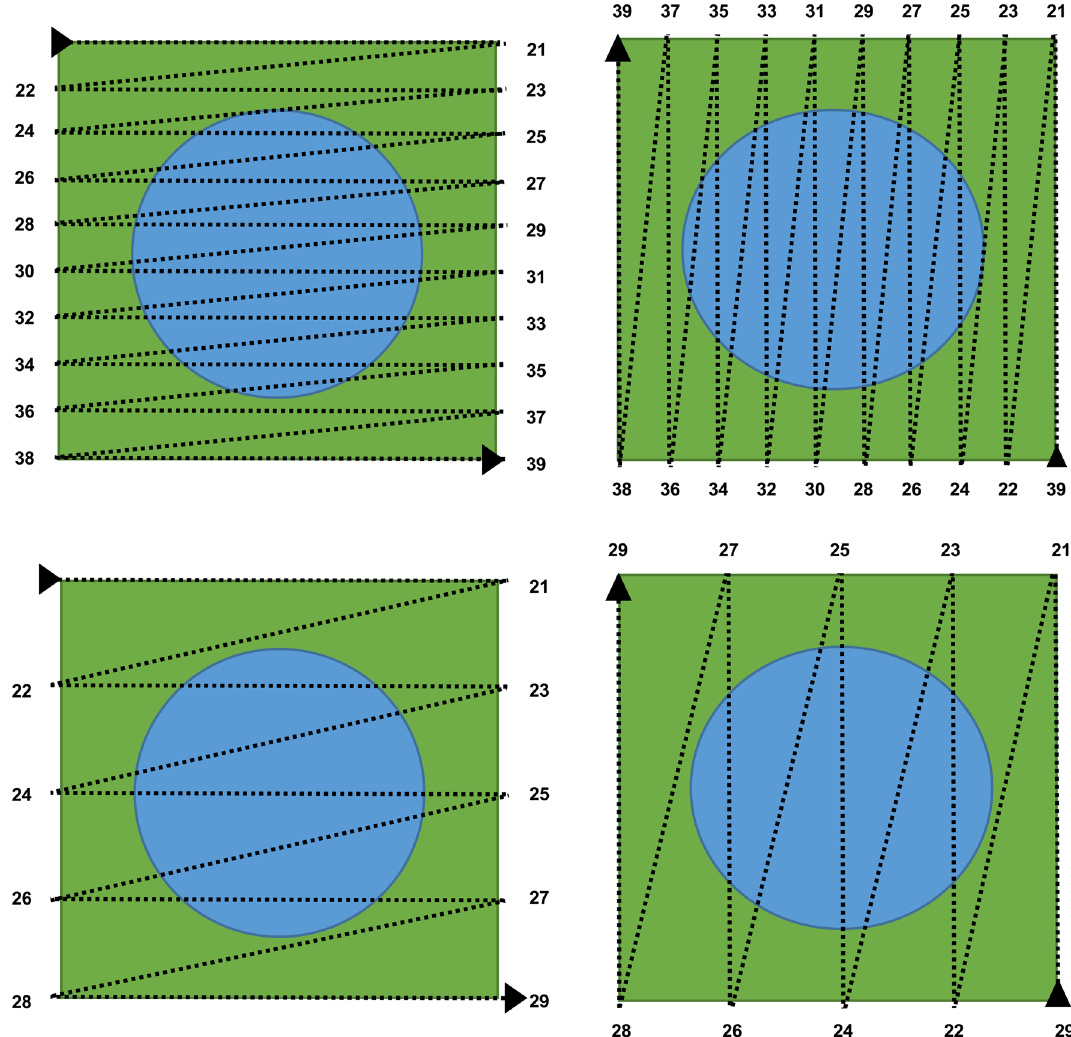
Fig. 4 Schematic representation of the manually tracked pattern during laser irradiation (top) and perioflow treatment